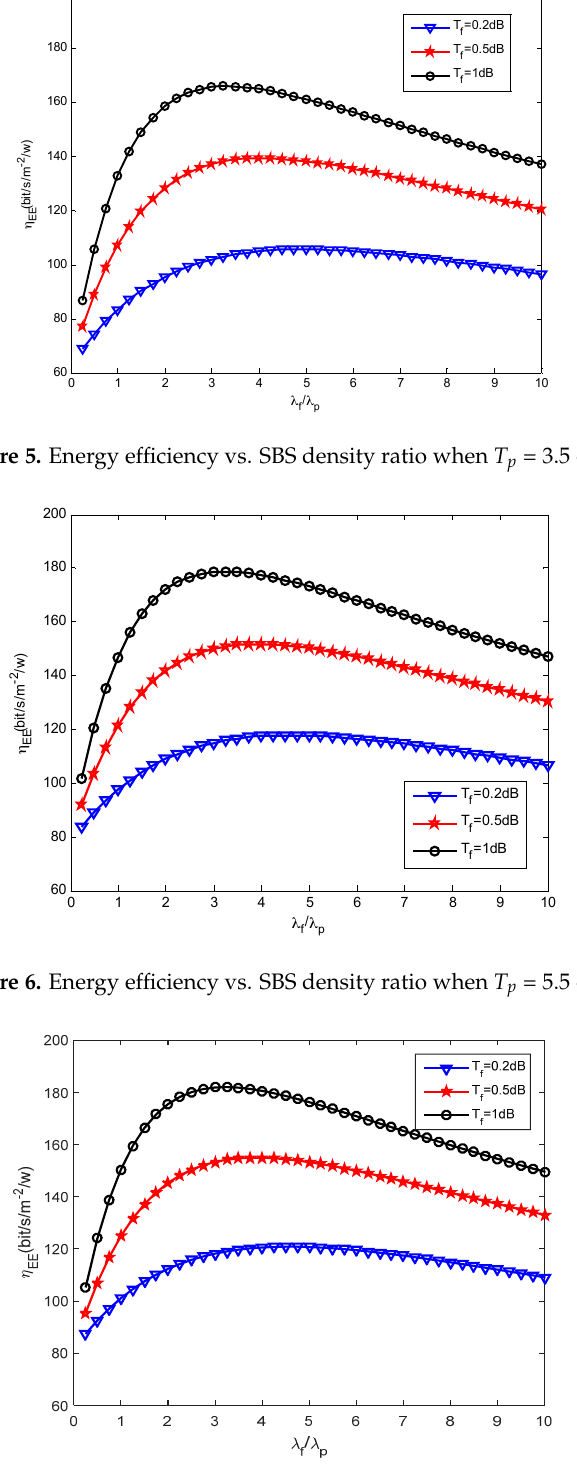
Figure 7. Energy efficiency vs. SBS density ratio when T p = 6.5 dB.